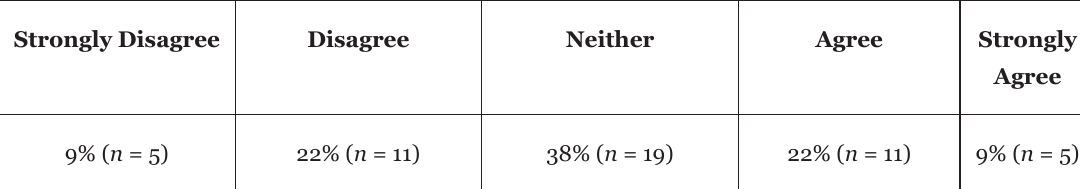
Strongly Disagree Disagree